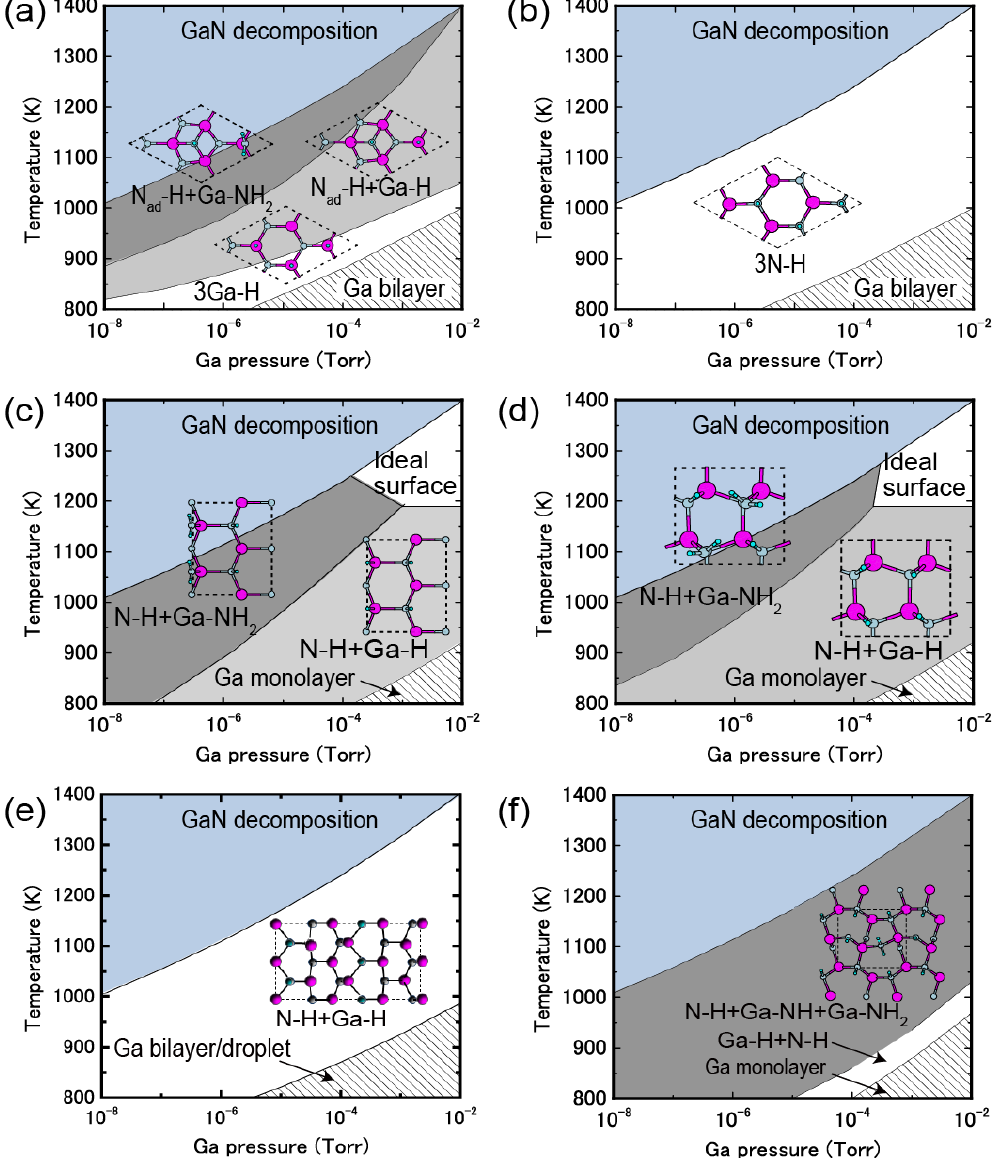
Figure 27. Calculated H-adsorbed GaN surface phase diagrams for polar ( a ) (0001) and ( b ) (cid:4666)0001(cid:3364)(cid:4667) ; nonpolar ( c ) (cid:4666)11(cid:3364)00(cid:4667) and ( d ) (cid:4666)112(cid:3364)0(cid:4667) ; and semipolar ( e ) (cid:4666)11(cid:3364)01(cid:4667) and ( f ) (cid:4666)112(cid:3364)2(cid:4667) orientations as a function of temperature and Ga BEP under high H ( p = 76 Torr) conditions. Top surface structure views are also presented. Large, small, H2 and tiny circles represent Ga, N, and H atoms,